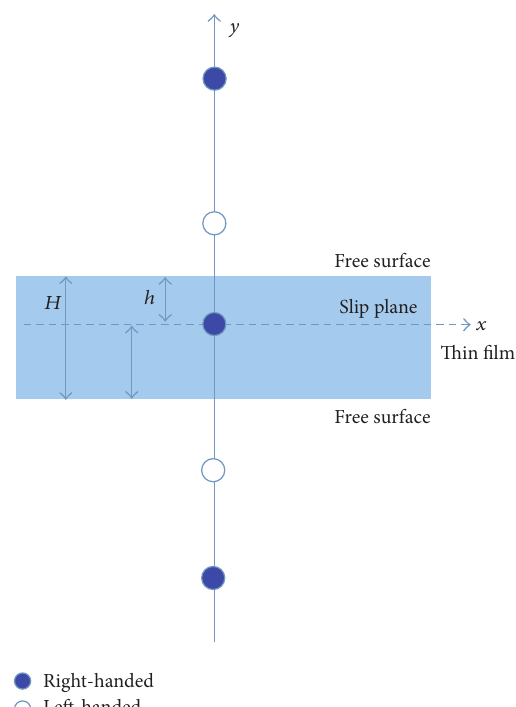
Figure 1: An array of imaginary dislocations of the original screw dislocation in the thin film. The slip plane of the original screw dislocation is parallel to the surfaces of the thin film and the effects of the surfaces can be described by the array imaginary dislocations. 𝐻 is the thickness of nanofilms, and ℎ | (𝐻 − ℎ) shows the position of slip